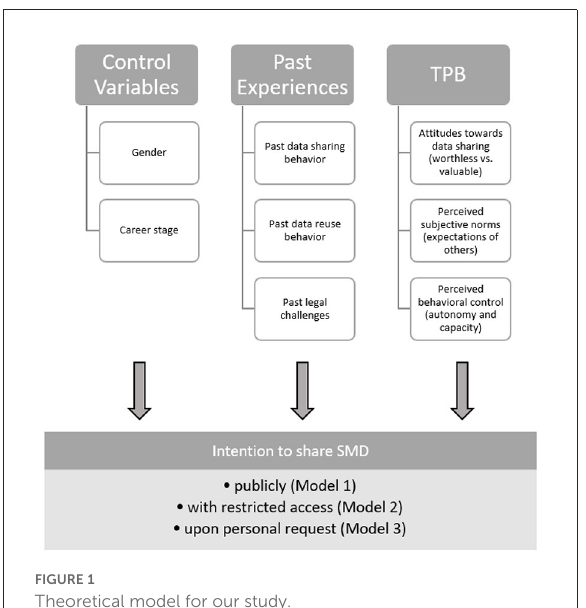
FIGURE1 Theoretical model for our